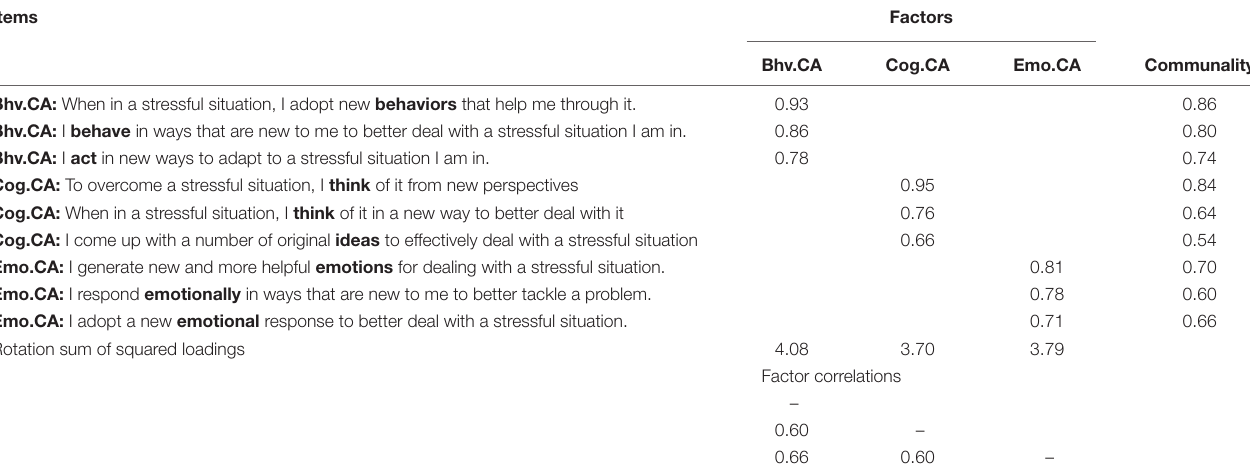
TABLE 1 | Factor analysis results for the creative adaptability